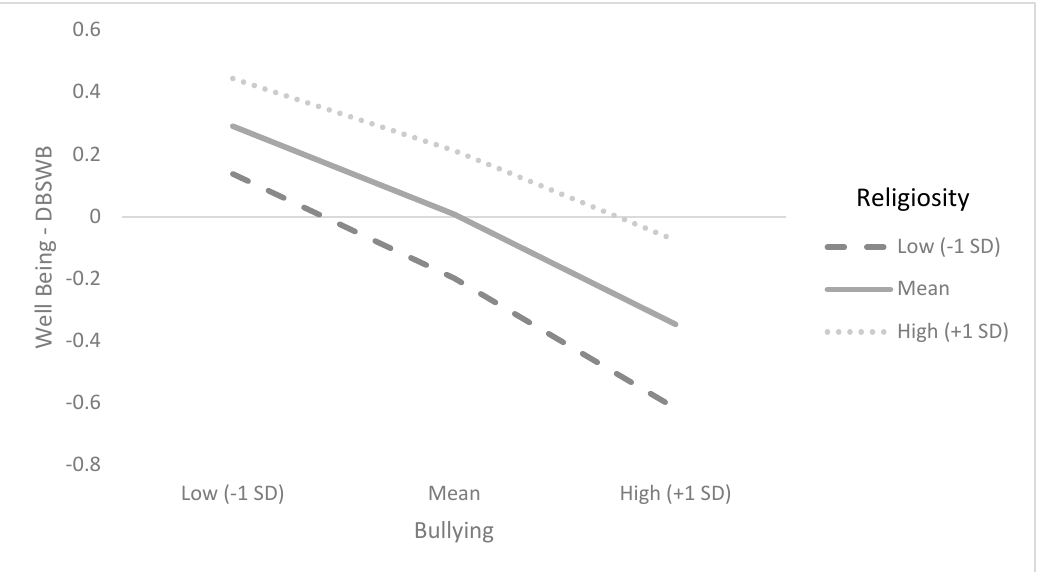
Figure 1. Interaction between child religiosity and bullying victimization in predicting DBSWS.